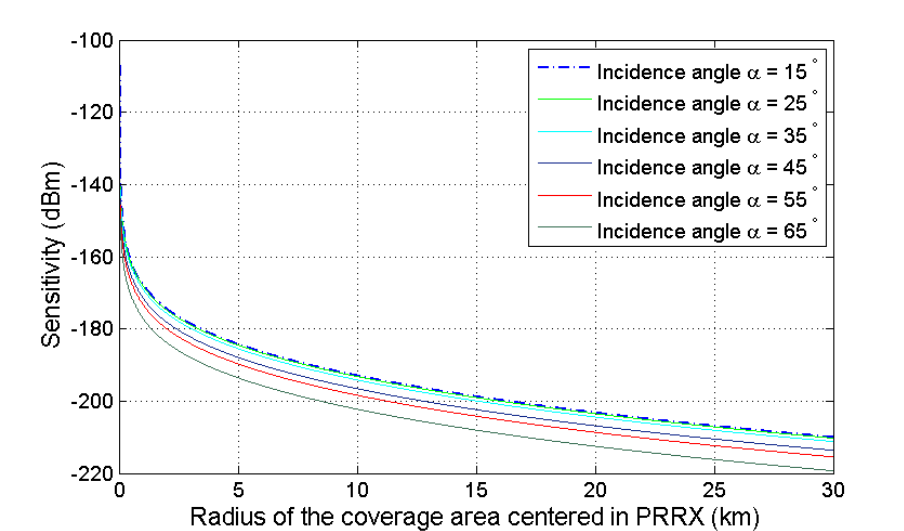
Figure 19. Coverage area of PAZ as the OI depending on the sensitivity of the system and the incidence angle of the satellite’s illumination